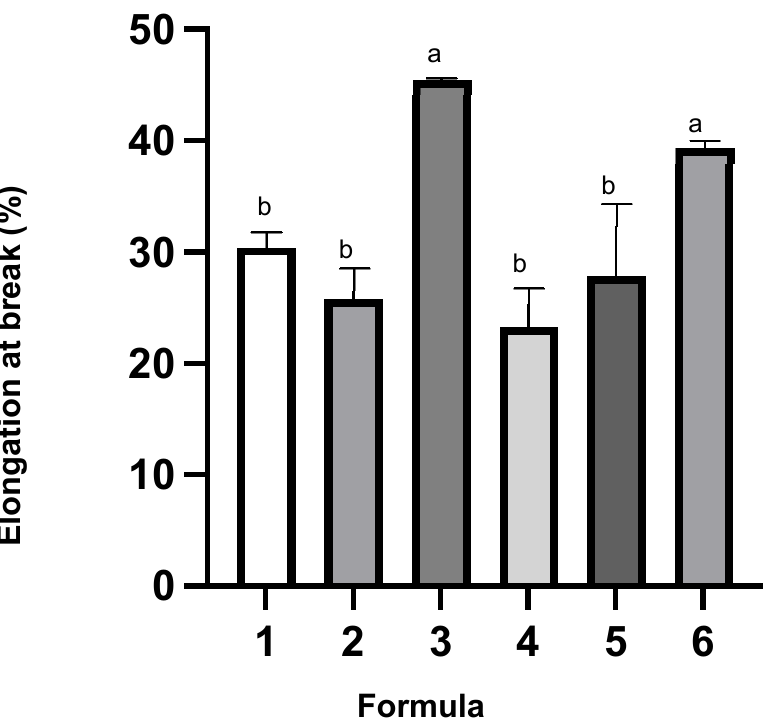
Figure 4. Percent elongation at break (%) of the film. The different letters represent a significant difference of p < 0.05. The error bar indicates the standard deviation (n = 3).